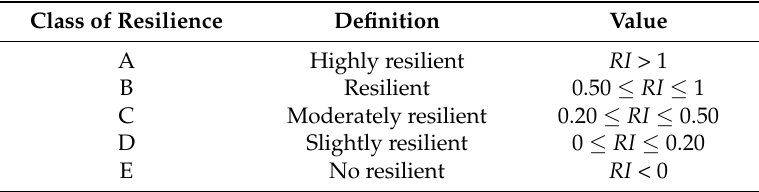
Table 4. Classes of reservoir resilience, definitions, and